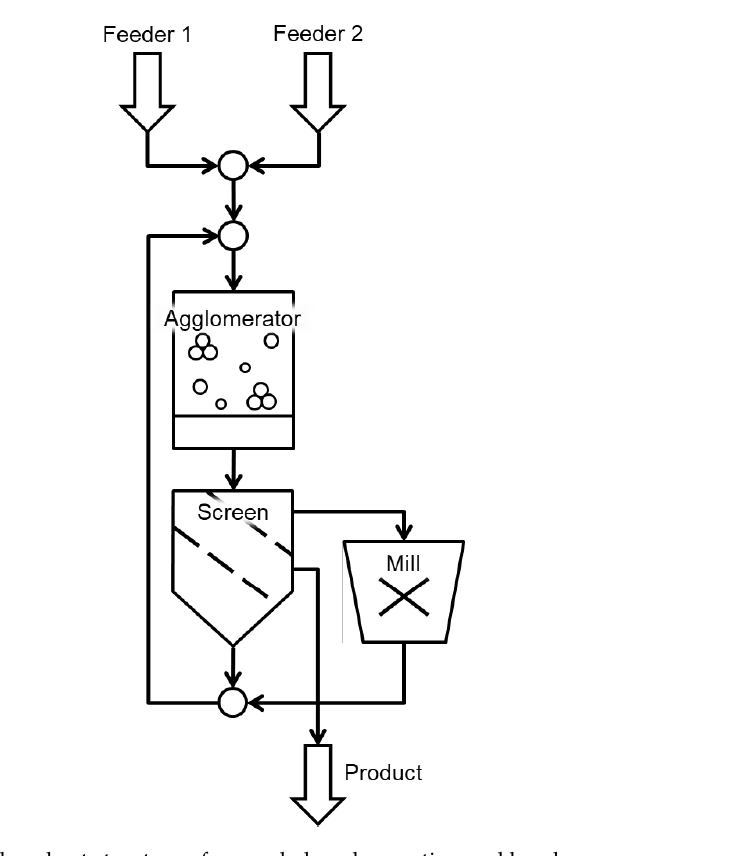
Table 4. Model parameters used for coupled agglomeration and breakage process.